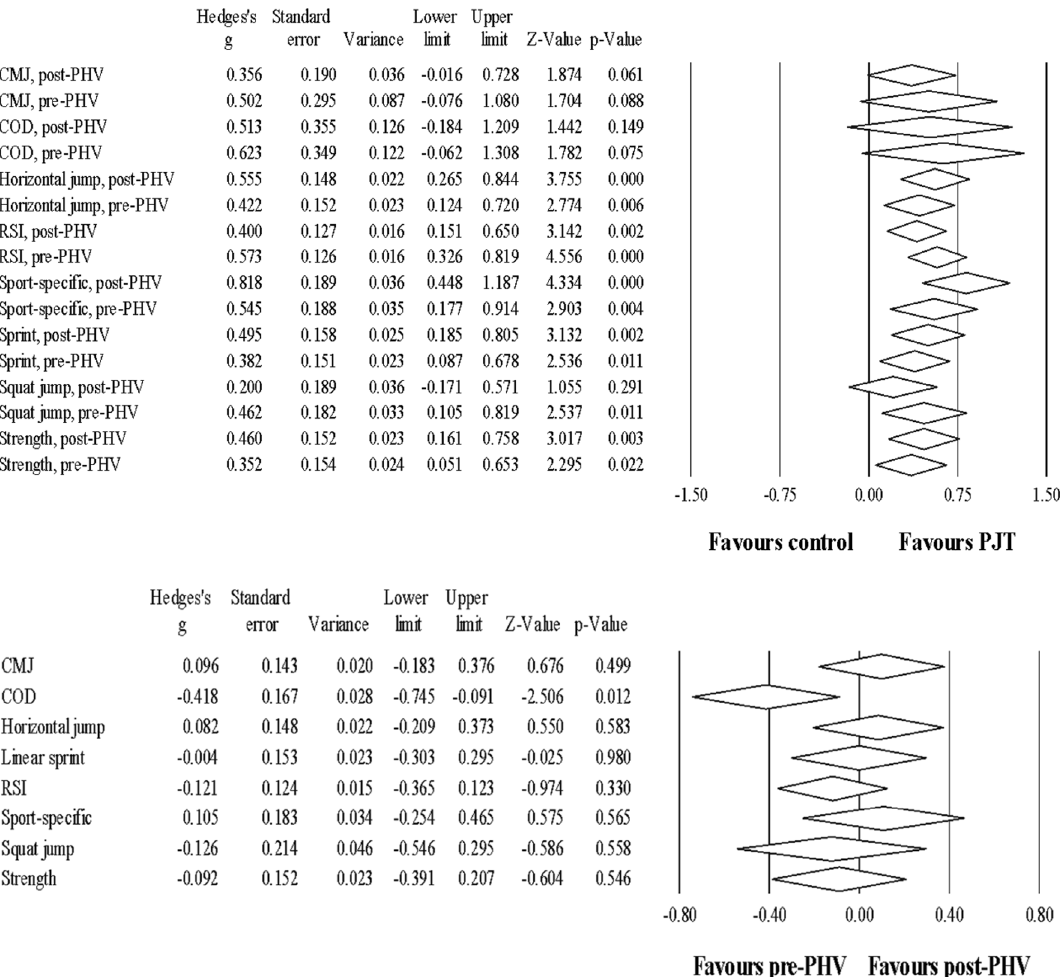
Fig. 2 Upper figure: changes in physical fitness and sport‑specific performance outcomes after PJT compared to controls in both pre‑PHV and post‑PHV participants. Lower figure: changes in outcomes after PJT in pre‑PHV compared to post‑PHV participants. CMJ : countermovement jump. COD : change of direction speed time. PHV : peak height velocity. PJT : plyometric jump training. RSI : reactive strength